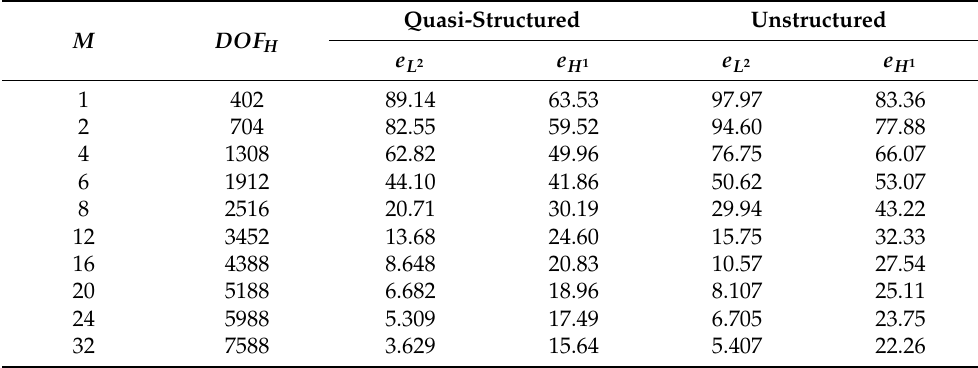
Table 6. Elasticity problem. Case 2 (non-homogeneous boundary conditions). Unstructured coarse grids. Relative L 2 and H 1 error in %. DOF h = 170,460.